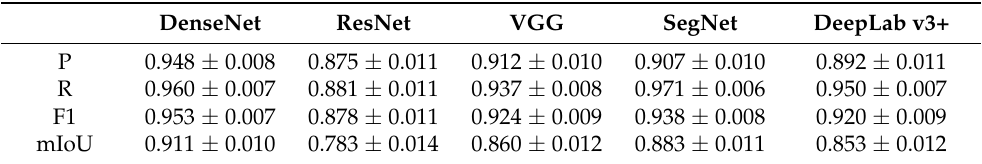
Table 3. The derived P, R, F1 score and mIoU of the VGG, ResNet, DenseNet, SegNet, DeepLab v3+ models with 95% confidence interval. The optimal value for each metric is